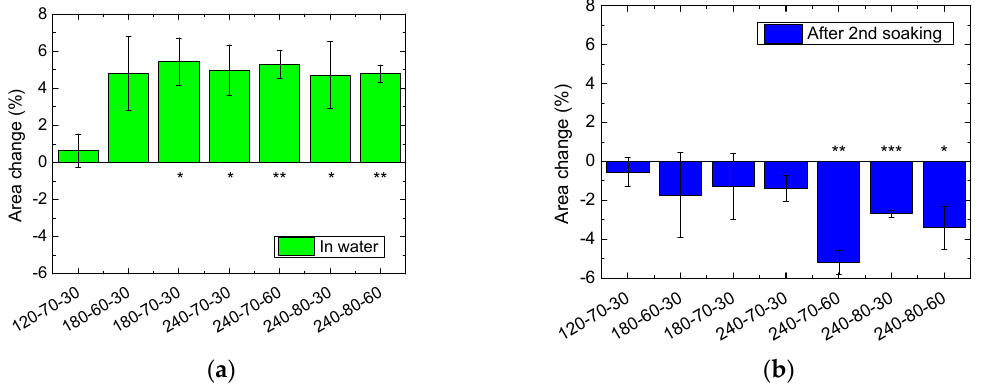
Figure 6. Percentage change of the areas of the electrospun PAN nanofiber mats ( a ) during exposition to water; ( b ) after exposure to water and drying. Statistical significance is depicted by * ( p < 0.05), ** ( p < 0.01) or *** ( p < 0.002), respectively.